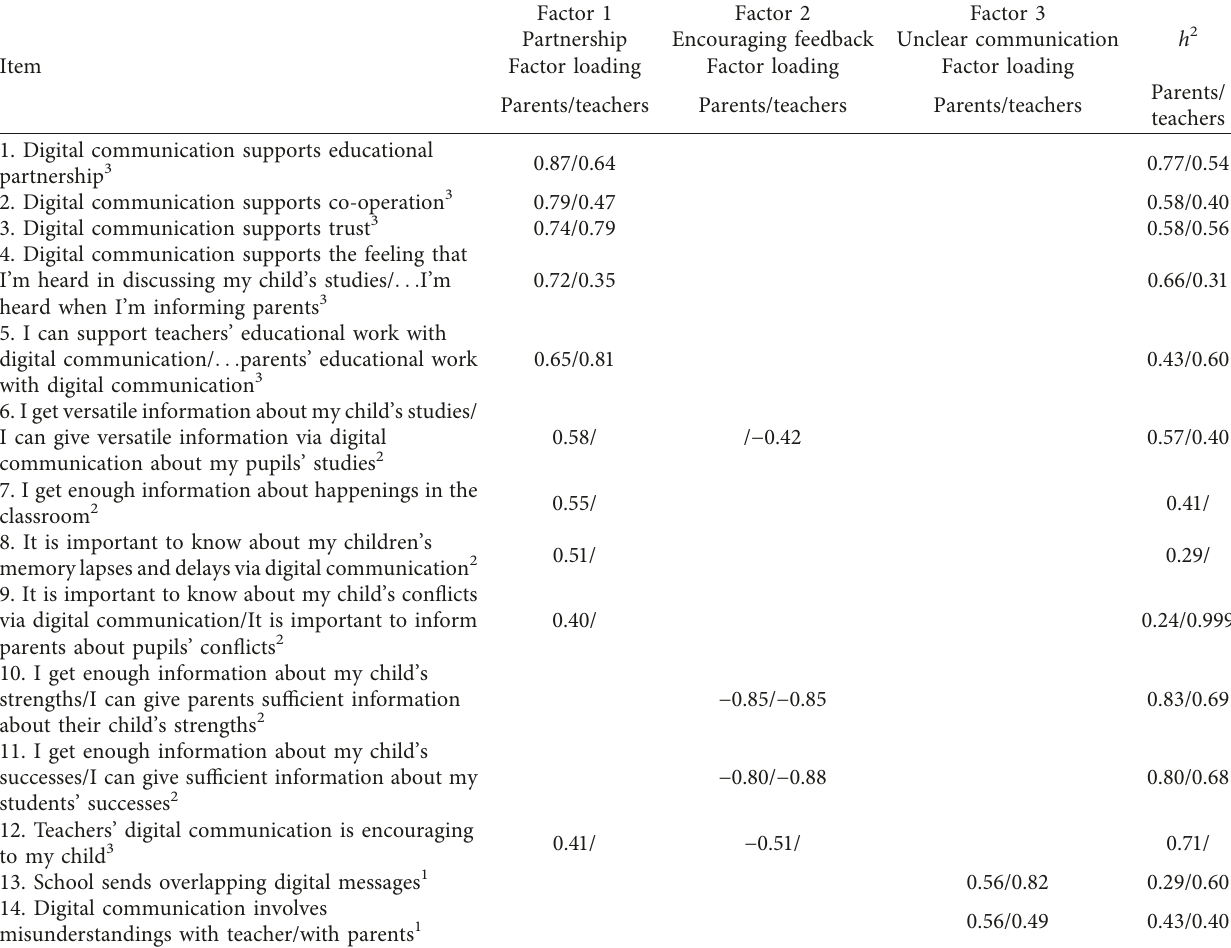
Table 2: Rotated factor structure of the DCS for parents and teachers.